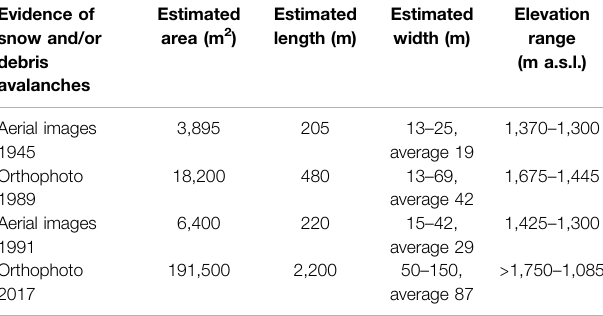
TABLE 7 | Comparison of area, length, width, and elevation range of the January 18, 2017 Rigopiano avalanche with respect to the snow and/or debris avalanche documented on the 1945 and 1989 – 1991